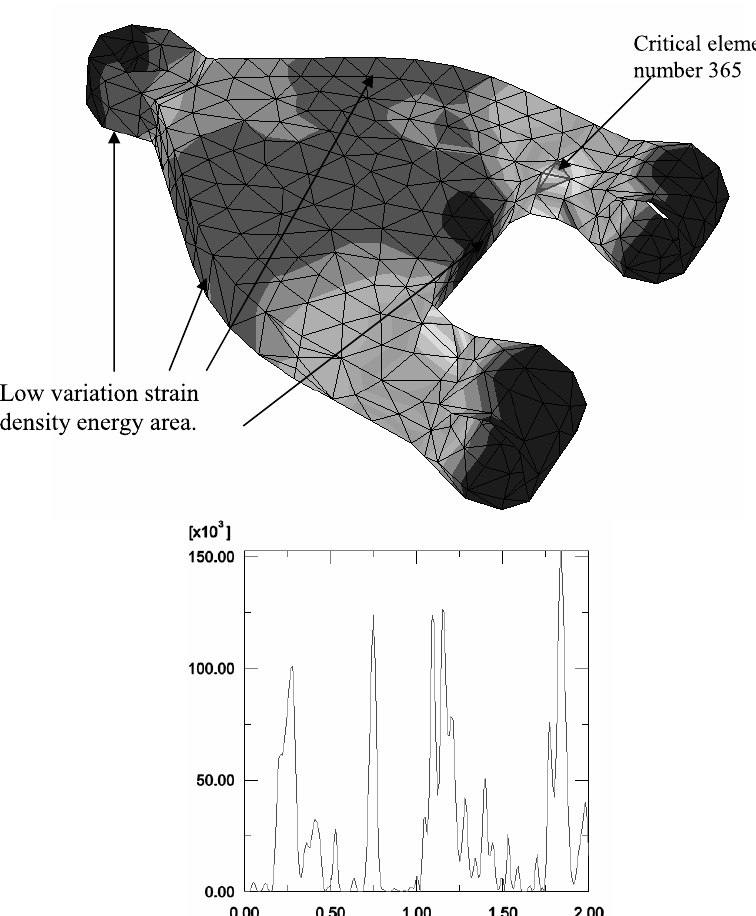
Fig. 7. SENER profile and critical SENER element signal of reference